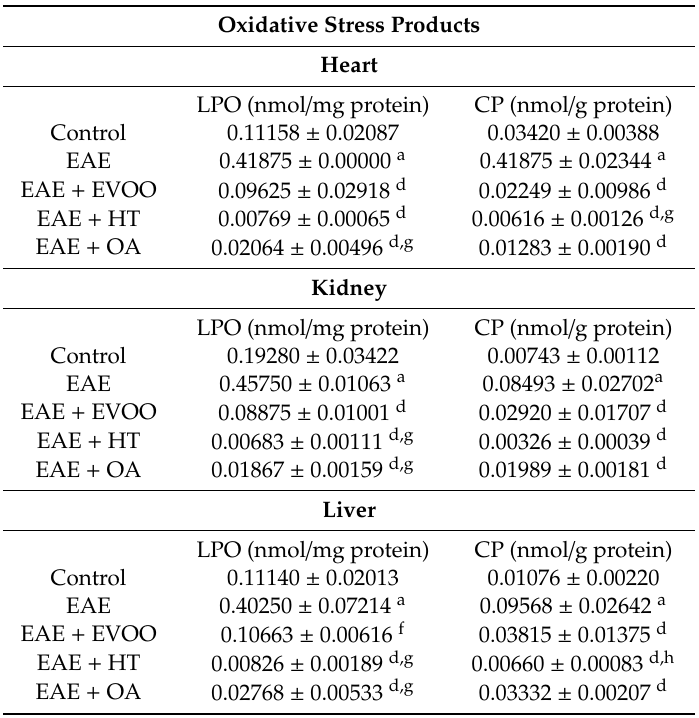
Table 2. Oxidative stress products in the heart, kidney, and liver.